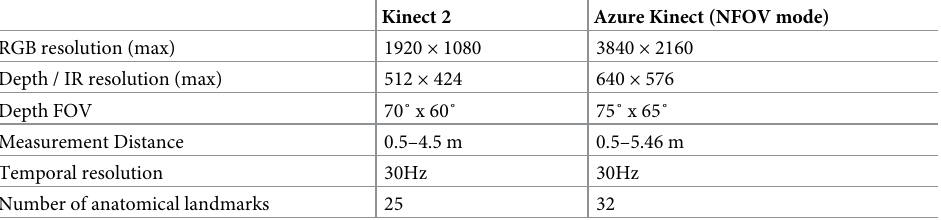
Table 1. Comparison technical specifications for Kinect 2 and Azure Kinect in near field of view mode